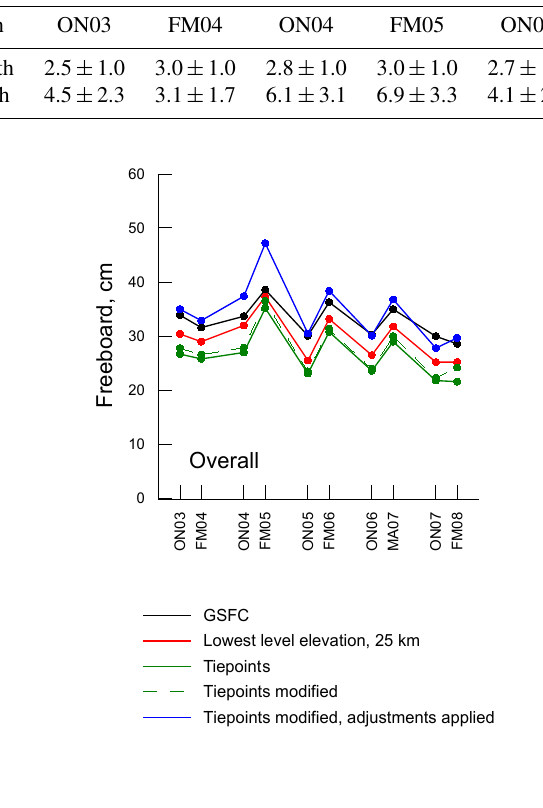
Table 3. Mean ± SD of the adjustments of freeboard retrieved by the TP method to account for snow depth in refrozen leads and for lead width with respect to the size of the ICESat footprint (cm). The adjustments are estimated following the methods described in Kwok and Cunningham (2008) and Kwok et al. (2009).